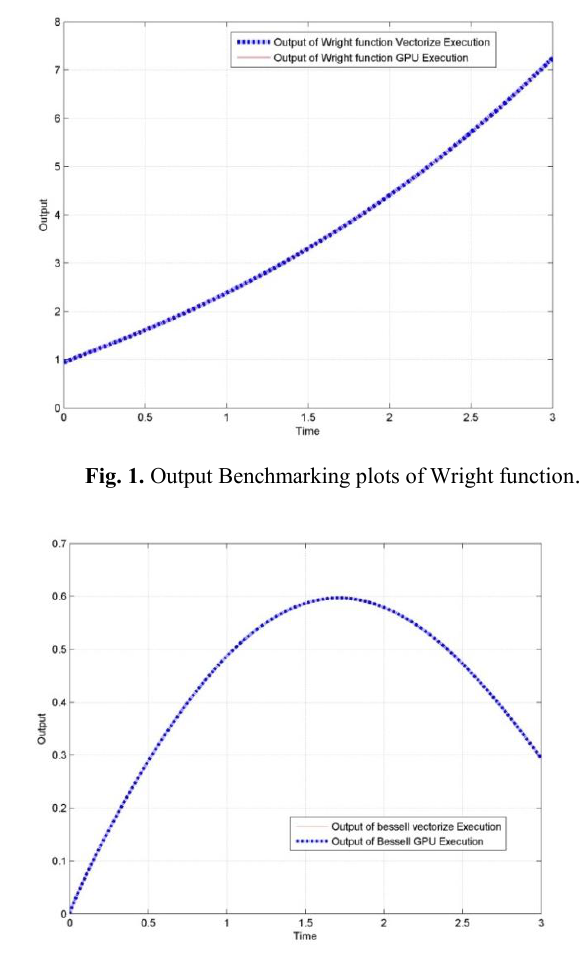
Fig. 2. Output Benchmarking plots of Bessell function.